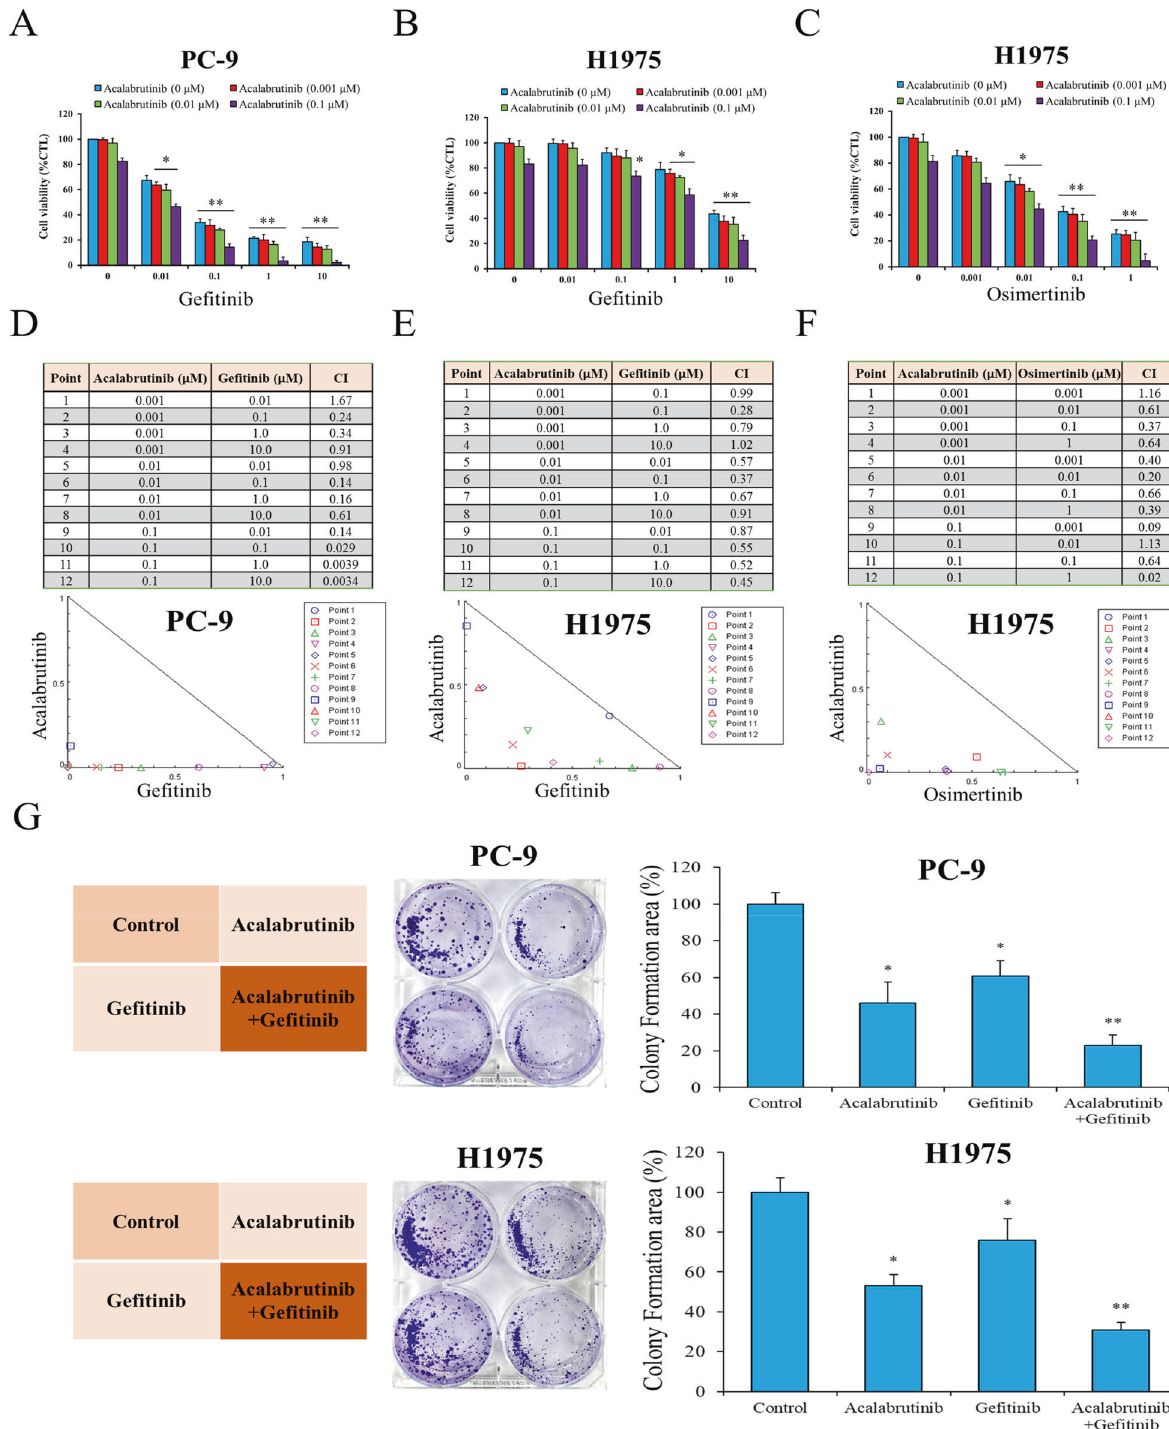
Fig. 6 BTK inhibitor Acalabrutinib promotes the anti-proliferative effects of Ge fi tinib/Osimertinib in Ge fi tinib-sensitive PC-9 cells and Ge fi tinib-resistant H1975 cells. Cell viability after treatment with different concentrations of TKIs and Acalabrutinib was evaluated by SRB assay in PC-9 cells and H1975 cells. A PC-9: Ge fi tinib + Acalabrutinib; B H1975: Ge fi tinib + Acalabrutinib; C H1975: Osimertinib + Acalabrutinib. Combination index (CI) for drugs and isobolograms were used to illustrate the synergistic effects of each two drugs in PC-9 cells and H1975 cells. D PC-9: Ge fi tinib + Acalabrutinib; E H1975: Ge fi tinib + Acalabrutinib; F H1975: Osimertinib + Acalabrutinib. G Colony formation assay showed colony number of PC-9 and H1975 cells after treatment of Acalabrutinib with or without Ge fi tinib signi fi cantly decreased. * p < 0.05, ** p <